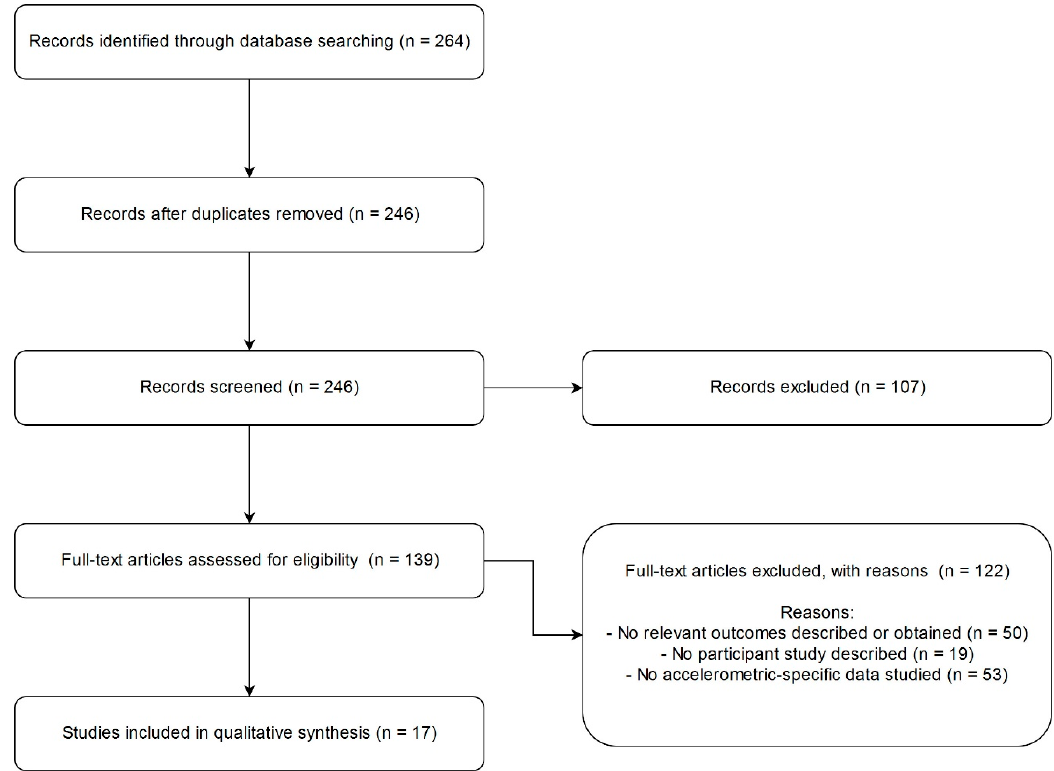
Figure 1. PRISMA chart detailing the article selection process.